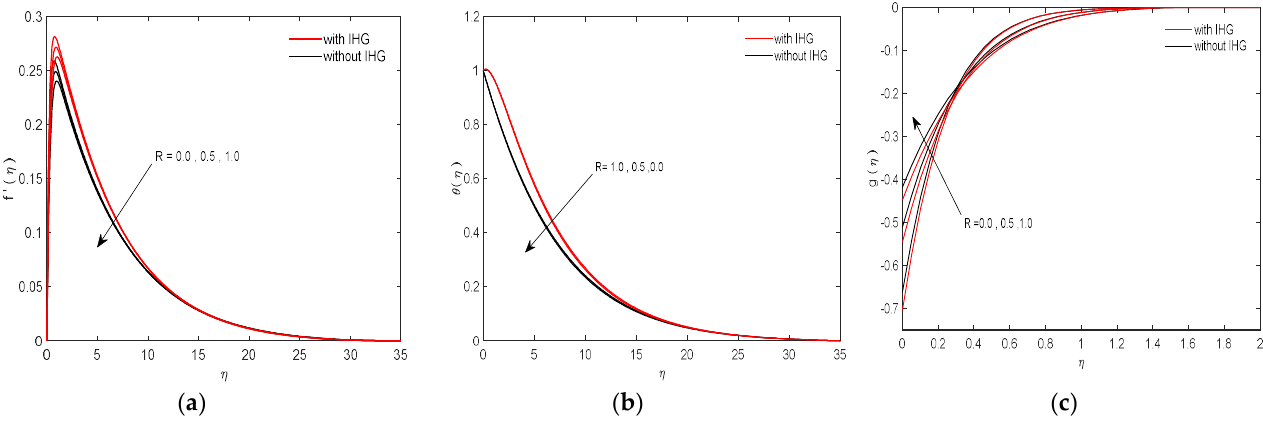
Figure 4. The effect of the micropolar parameter R on the ( a ) velocity profile, ( b ) temperature profile and ( c ) angular velocity profile for M = 1, λ = 0.5, c = 0, B = 0.2, φ 1 = φ 2 = 0.05, Da = 10, Rd = 3, n = 0.5, fw =